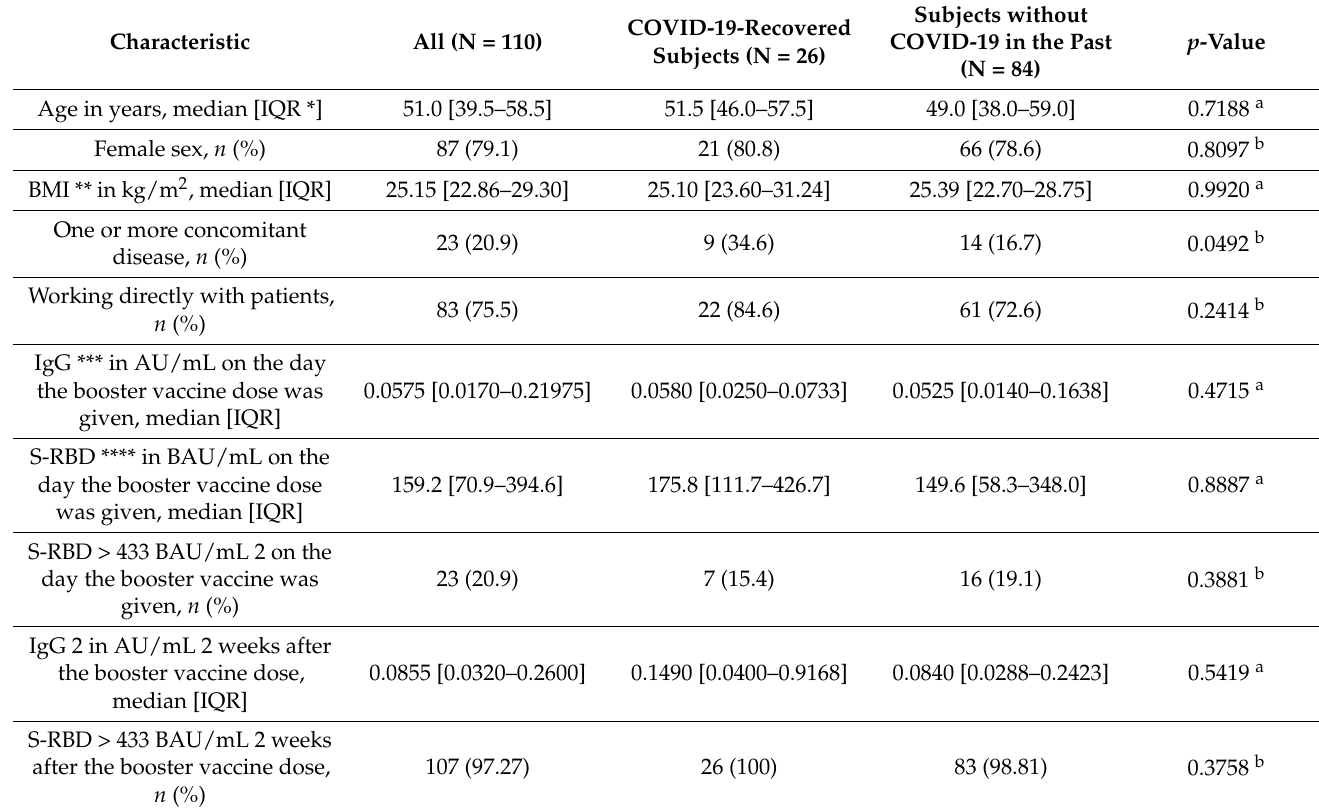
Table 1. Baseline characteristics stratified by COVID-19 infection status before vaccination with a booster dose of the BNT162b2 (Comirnaty)